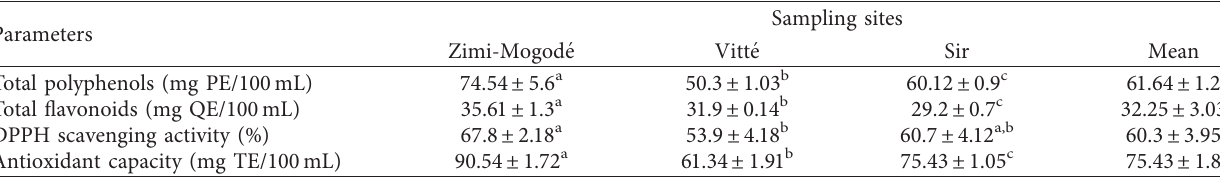
Table 4: Phenols and flavonoids contents, scavenging activity, and antioxidant capacity of the pummelo-based wine made in northern Cameroon.